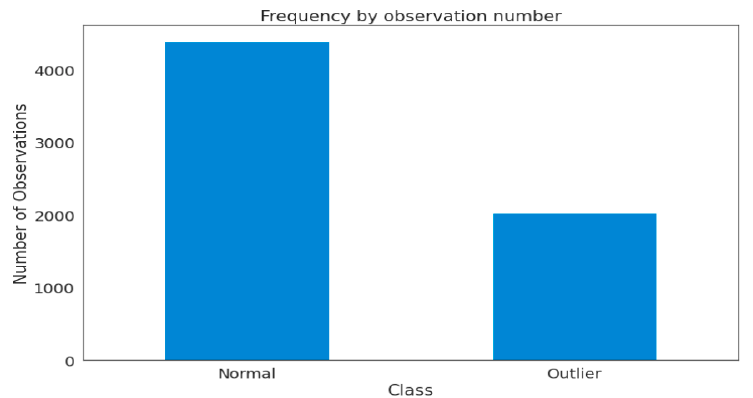
Figure 3. Visualization of the distribution of normal/outlier instances in the used dataset.